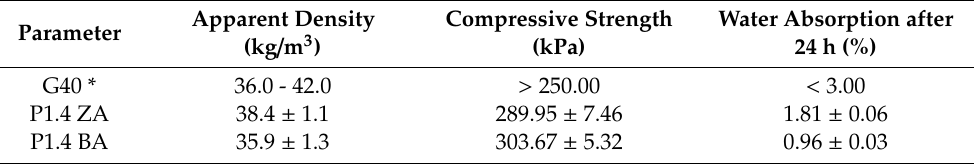
Table 3. Physico-mechanical properties comparison of commercial RPU / PIR foam for thermal insulation and foams with 0.4 Eq of bio-polyol